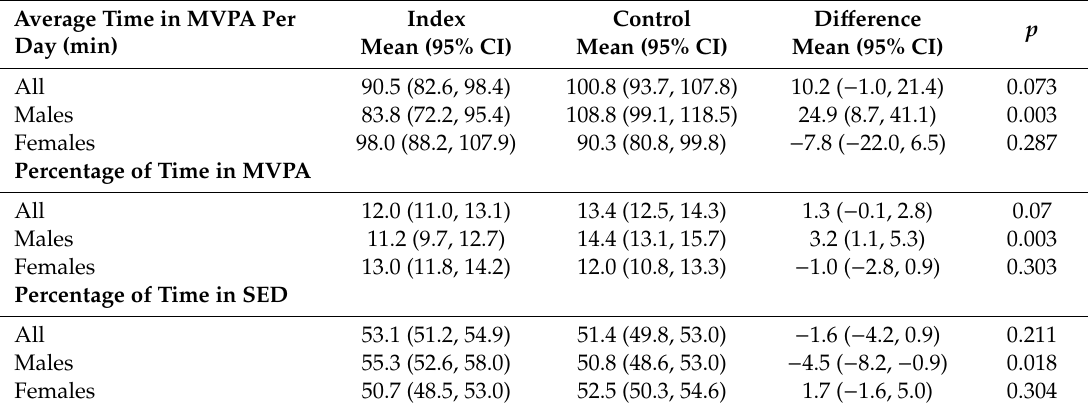
Table 2. Comparison of levels of PA between index and control children.